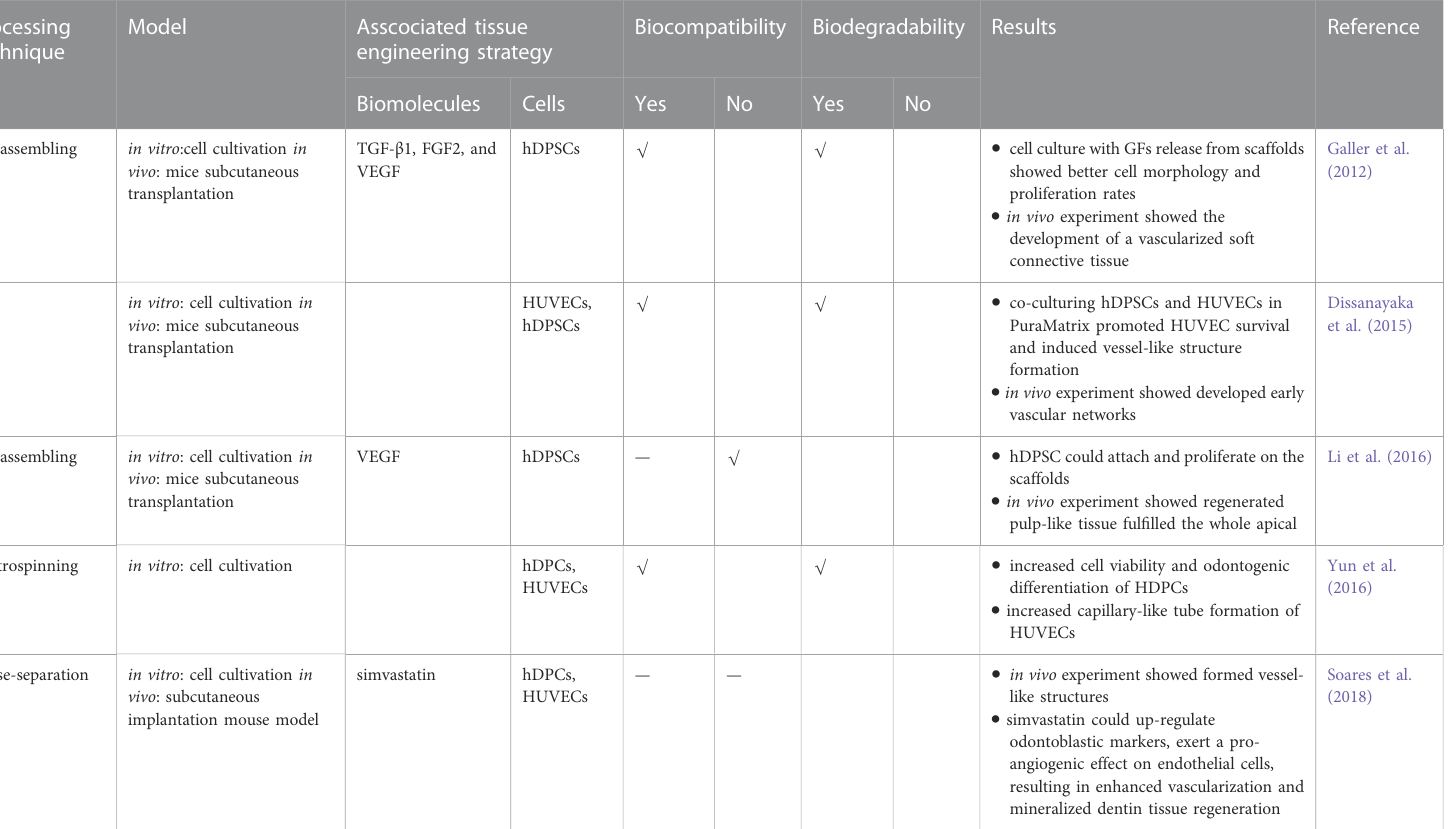
TABLE 3 Nano fi brous scaffolds for revascularization and